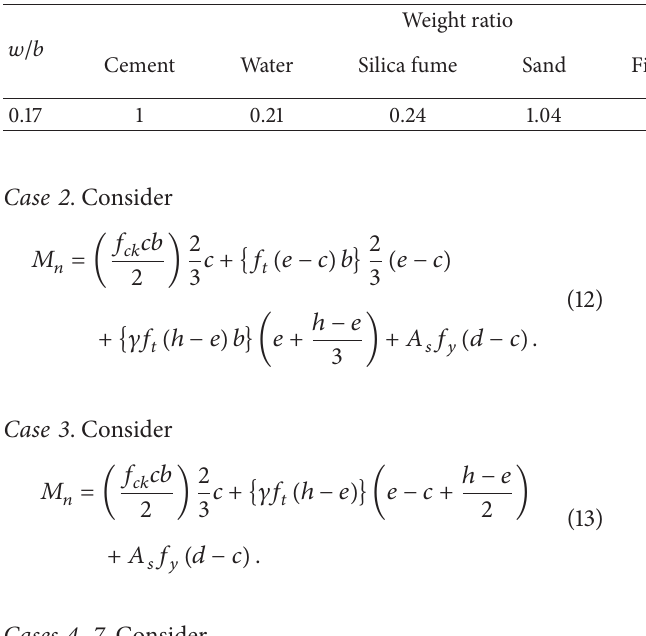
Table 1: Mix proportions.